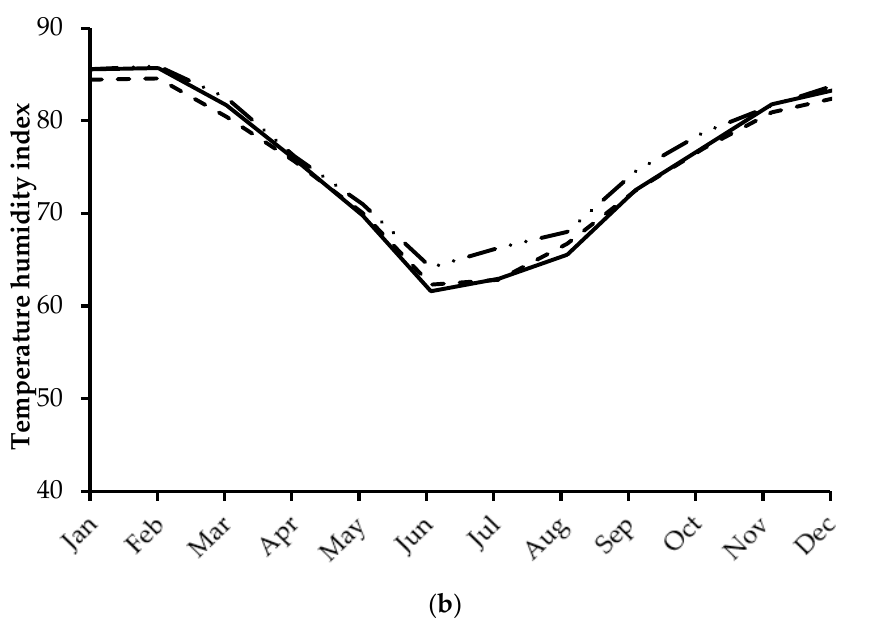
Figure 1. Average of the daily maximum temperature-humidity index (THI) by month ( a ) and monthly maximum THI ( b ) at 3 locations of sheep producing regions in western Victoria for the 5-year period 2013–2017 (Walpeup—loosely dashed double dotted line, Nhill—dashed line and Hamilton—solid line).